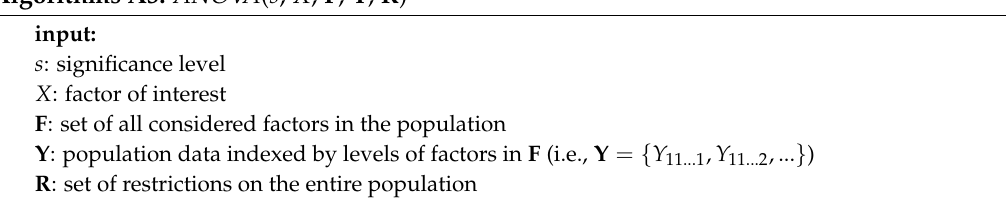
Algorithms A3. ANOVA ( s , X , F , Y , R